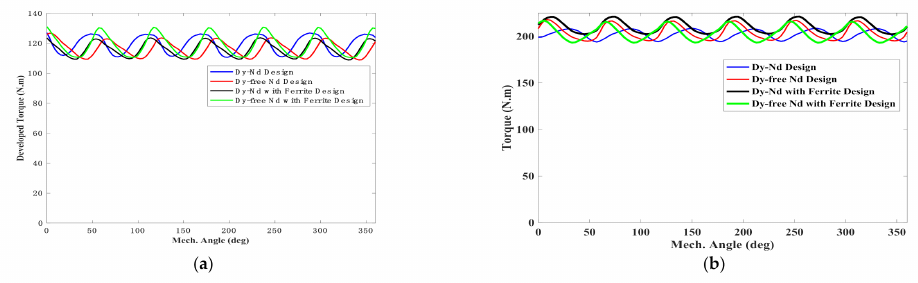
Figure 13. Torque capabilities for various designs ( a ) at rated current, ( b ) at peak current. The torque ripple in the considered configuration 12 slots/10 pole-pairs is significant due to the low least common multiple between the PM poles and FMP-Ps number. How- ever, by implementing various torque-ripple reduction techniques, the torque ripple can be